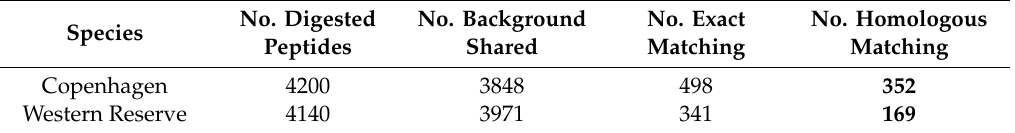
Table 6. This table shows the number of taxon-specific peptides from the VACV Copenhagen and VACV Western Reserve strain after (i) in silico digest, (ii) exact matching, and (iii) homologous matching (80% background consensus threshold). Each target strain was compared against the background of the other strain and all reviewed virus proteomes. The second column provides the number of nonspecific peptides, i.e., the ones being shared with the background. No. Digested No. Background No. Exact No. Homologous Species Peptides Shared Matching Matching Copenhagen 4200 3848 498 352 Western Reserve 4140 3971 341